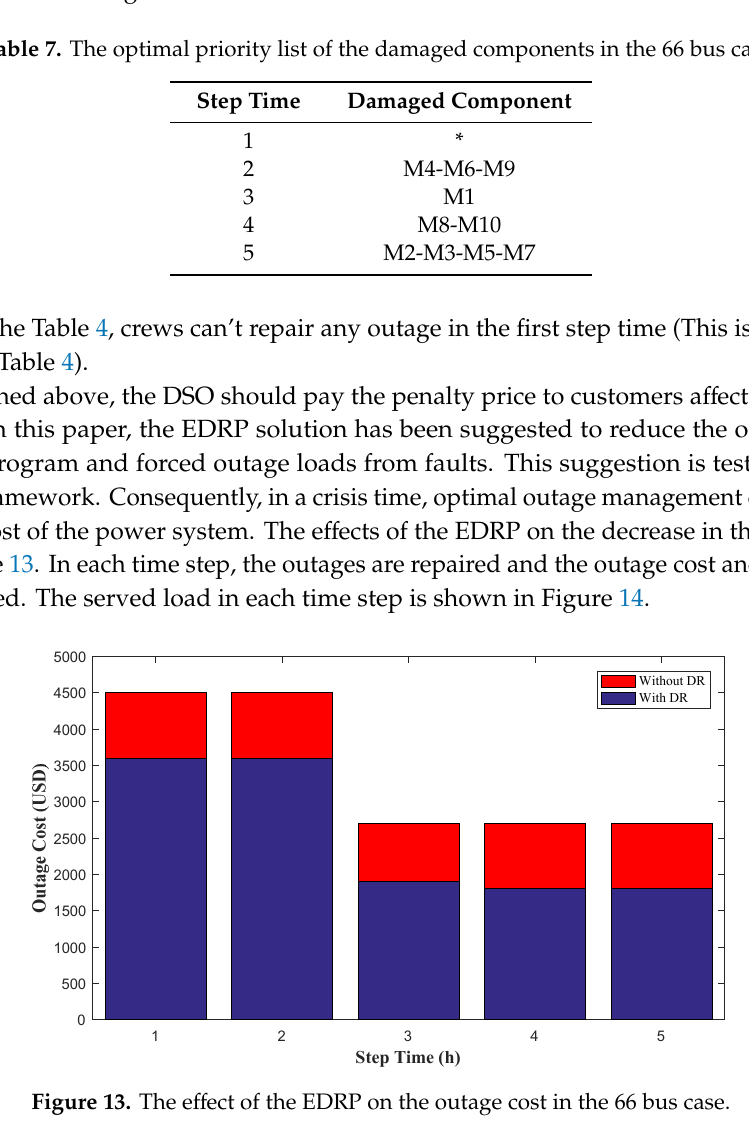
Figure 14. The effect of the EDRP on the served load in the 66 bus case. According to Figures 13 and 14, the served load is increased, and consequently, the outage cost is reduced in each step time. Furthermore, the outage cost is decreased impressively in the demand response scenario compared to without the demand response program scenario. Referring to Figure 14, it can be said that the EDRP causes an increase in the social welfare of the customers by increasing the served load value. 6. Conclusions In this paper, a new smart outage management system denoted by 𝑆𝑂𝑀𝑆 (cid:3005)(cid:3008)(cid:3046) (cid:3006)(cid:3005)(cid:3019)(cid:3017)(cid:3046) is provided. The EDRPs and the DGs are considered in the proposed framework to optimize the operation of the outage management system. In the first stage of the proposed framework, the clustering method is